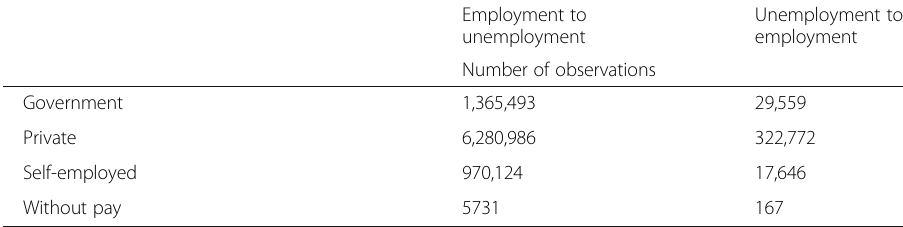
Table 11 Sample size for the heterogeneous test (Table 8) (Continued)